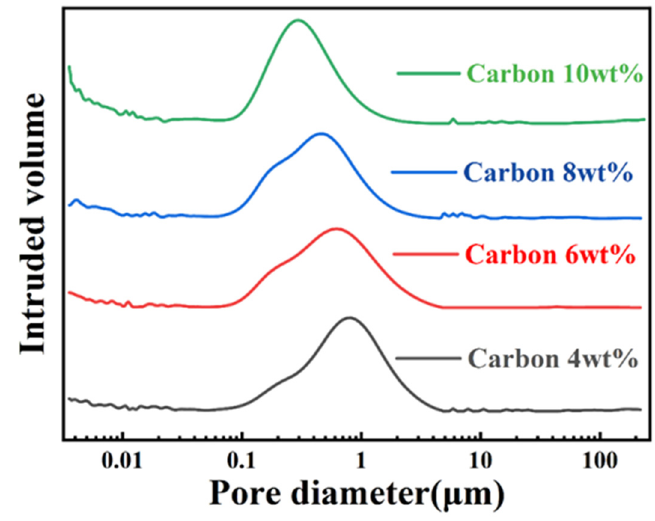
Figure 4. The pore size distribution of preforms with different CB content.